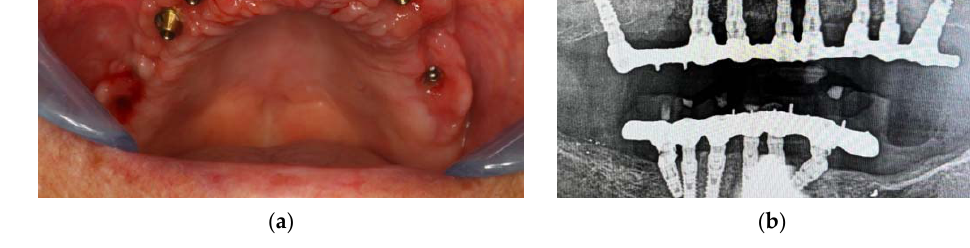
Figure 8. Clinical ( a ) and radiographic ( b ) healing.